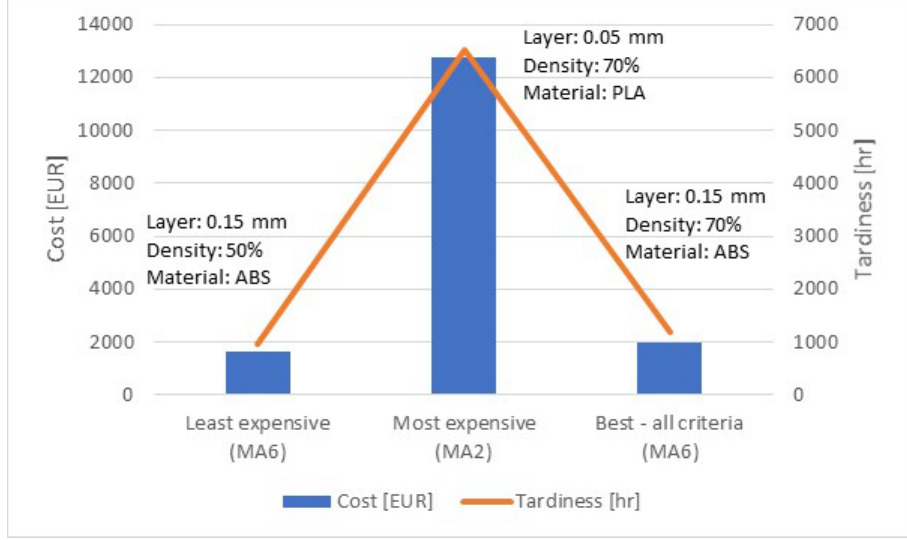
Figure 12. Test Case 2—Cost and tardiness of different configurations.